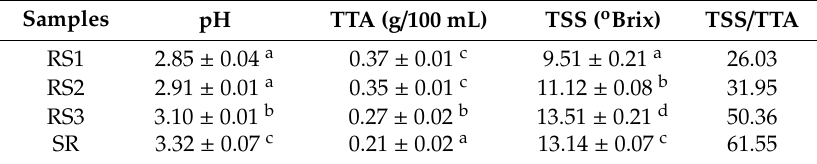
Table 1. pH, total acidity and total soluble solids of Carissa edulis fruit samples.